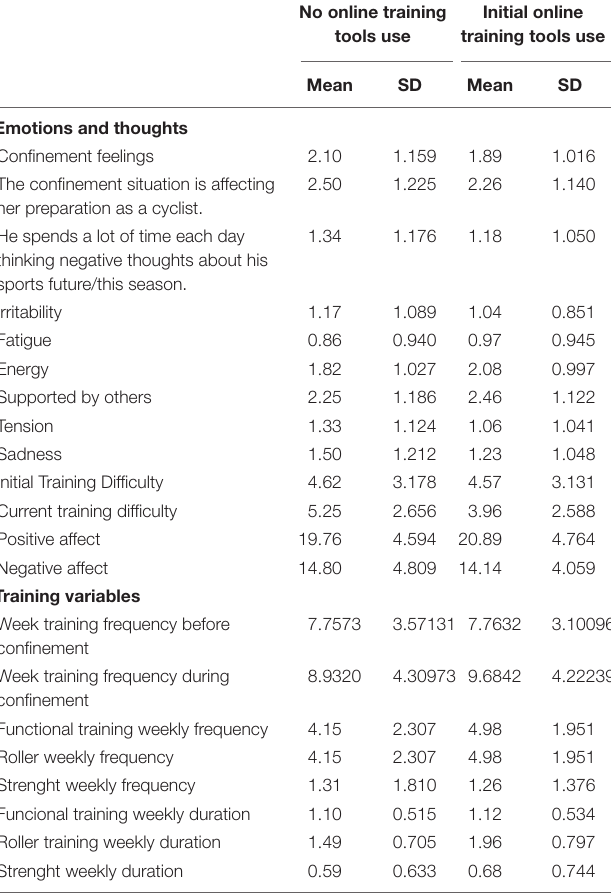
TABLE 2 | Mean and standard deviation (SD) of cyclists that began to use training apps during the confinement compared to those that did not use (nor begin) online training